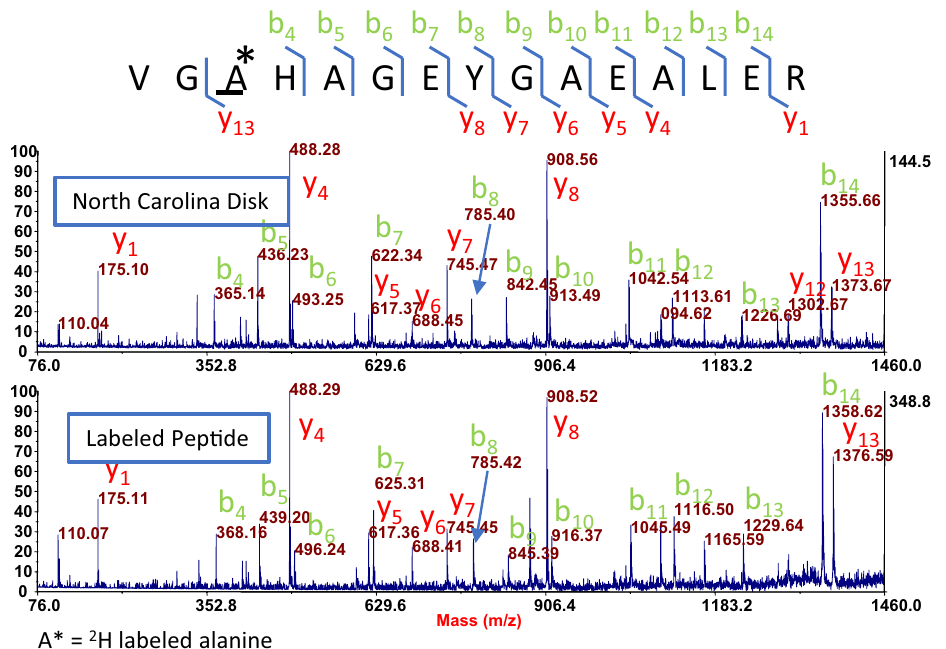
Figure 3. Comparison of North Carolina hemoglobin peptide VGAHAGEYGAEALER spectrum with 2 H labeled synthetic peptide. Spectral comparison between human hemoglobin peptide VGAHAGEYGAEALER (shared with Pan paniscus (bonobo) a close primate relative of humans) identified in the North Carolina disk, and its synthetic counterpart with matching b and y